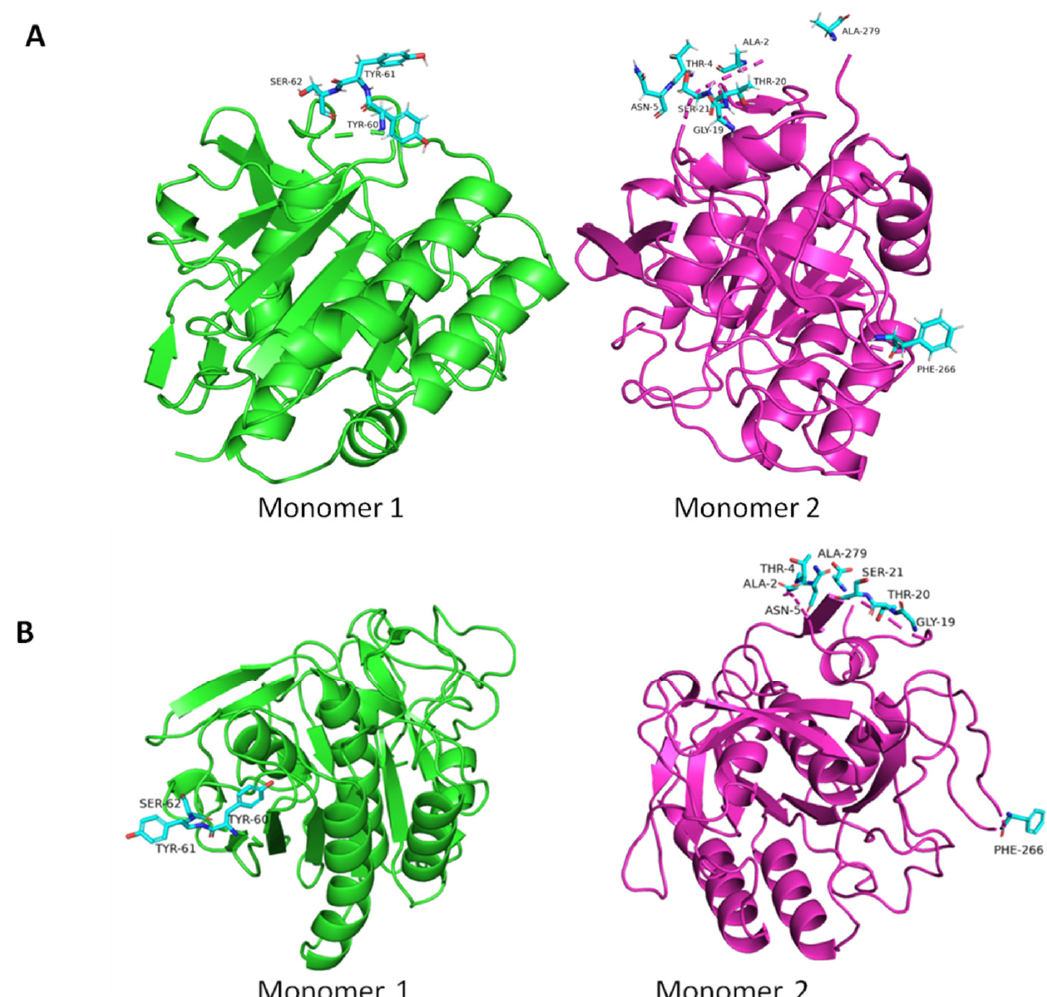
Figure 2. The initial ( A ) and dissociated ( B ) structures of the dimer at 70 °C at the 0th and 100th nanosecond of simulation, correspondingly. The backbone of residues with the highest RMSF values (the most mobile) are represented with cyan sticks.